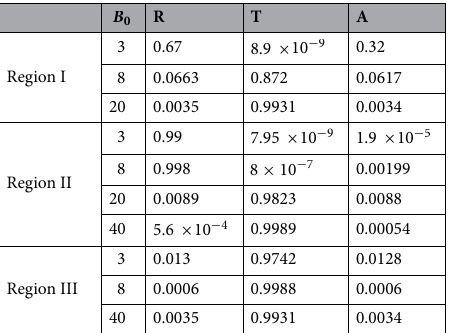
Table 3. A comparison of various coefficients with different external magnetic field.